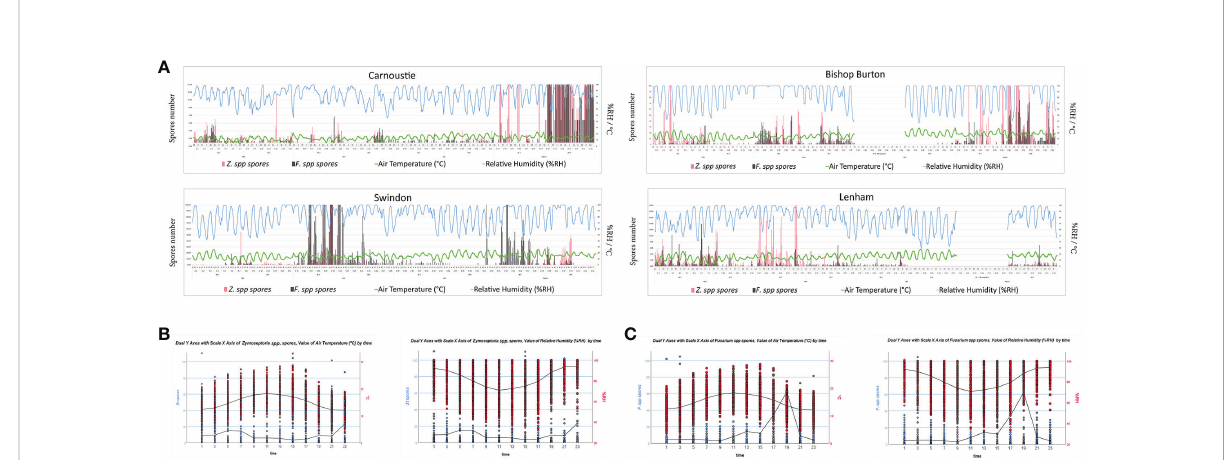
FIGURE 4 (A) Temporal distribution of Z. spp. ( Zt , Pink bars) and Fusarium spp. ( F. spp. Grey bars) ascospore release, plotted on the primary Y axis, against air temperature (Green line) and relative humidity (Blue line), plotted on the secondary Y axis; for all the four sites. (B) Dual Y axis with scale X axis of Zymoseptoria spp. or Fusarium spp. ascospores and value of air temperature by 2h timepoints. Values for all the 4 sites were used to generate the negative correlation curve. Graphs with IBM SPSS Statistics 26. (C) Dual Y axis with scale X axis of Zymoseptoria spp. or Fusarium spp. ascospores and value of relative humidity by the 2h timepoints. Values for all the 4 sites were used to generate the positive correlation curve. Graphs with IBM SPSS Statistics